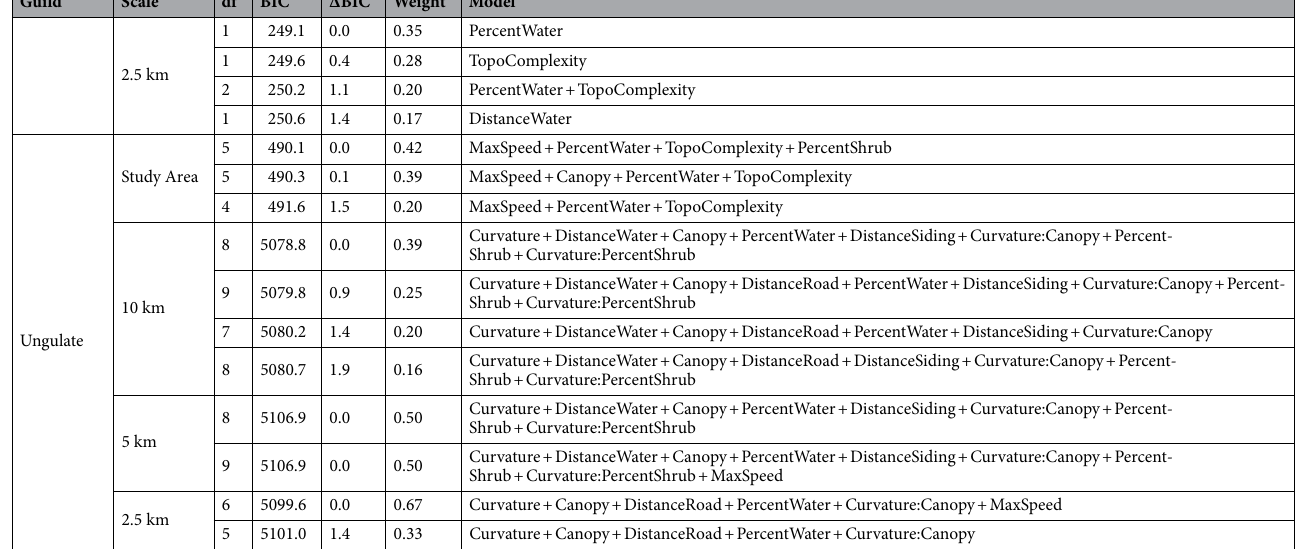
Table 3. Model selection for factors affecting wildlife railroad mortality assessed using random locations distributed throughout the study area using logistic regression and within scale specific distances of paired mortality sites using conditional logistic regression. Top ranked models were ≤ 2 ΔBIC of the top